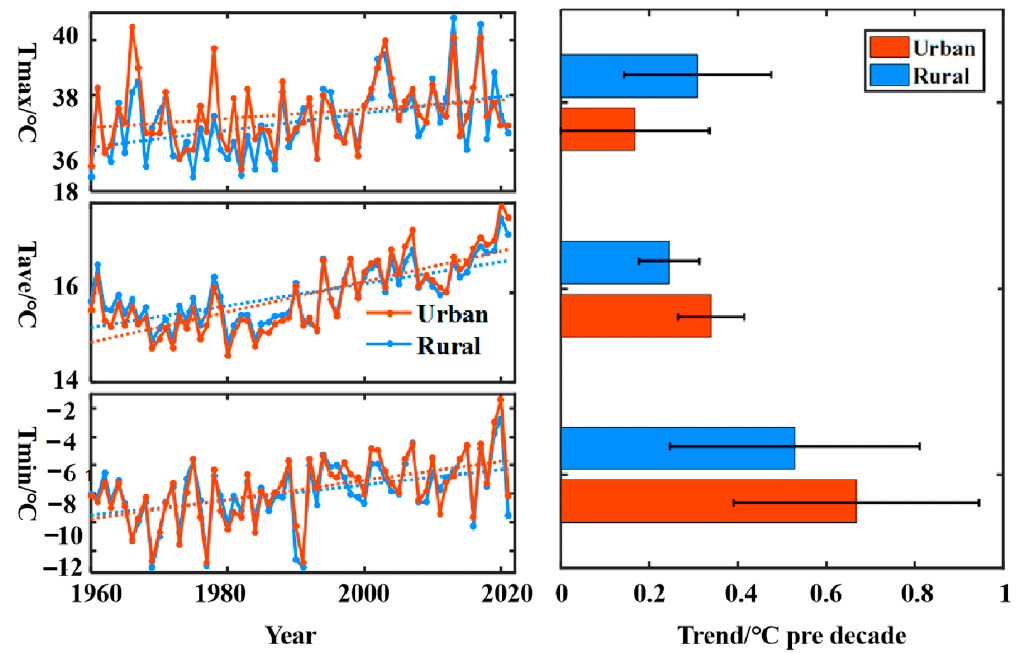
Figure 2. Time series for maximum/mean/minimum temperatures in urban areas and rural areas during 1960–2021. The red and blue dashed lines in the left-hand panel and the columns in the right-hand panel indicate their corresponding linear trends. Error bars in the right-hand panels indicate the 95% confidence interval.